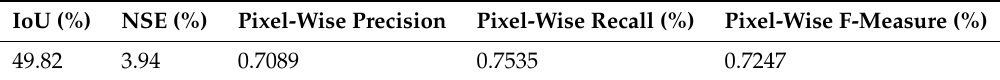
Table 2. The performance of our numeral spotting model (numerals vs. background) is presented with different metrics.